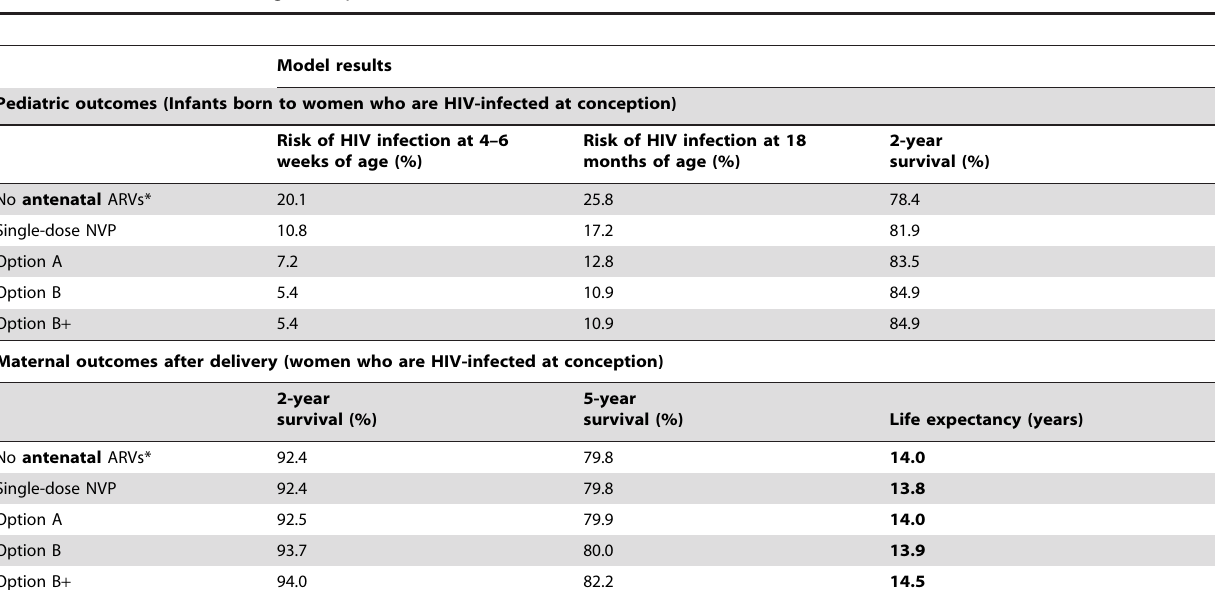
Table 3. Outcomes of strategies to prevent mother-to-child HIV transmission in Zimbabwe: Base-case model results.